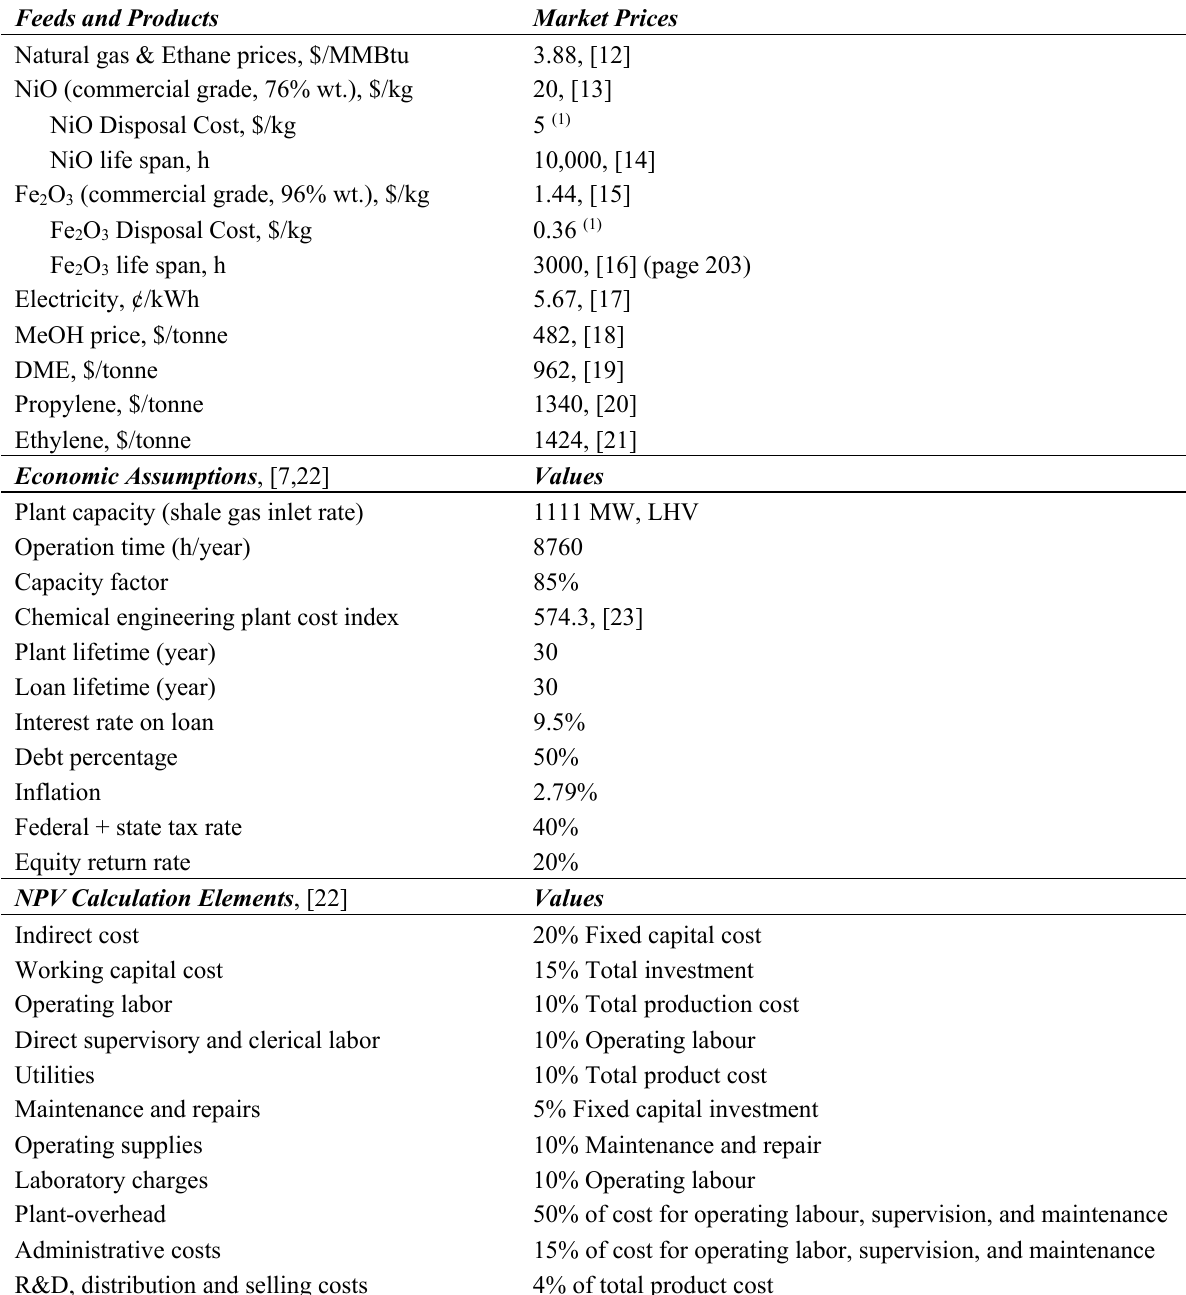
Table 1. Base-case market prices and economic